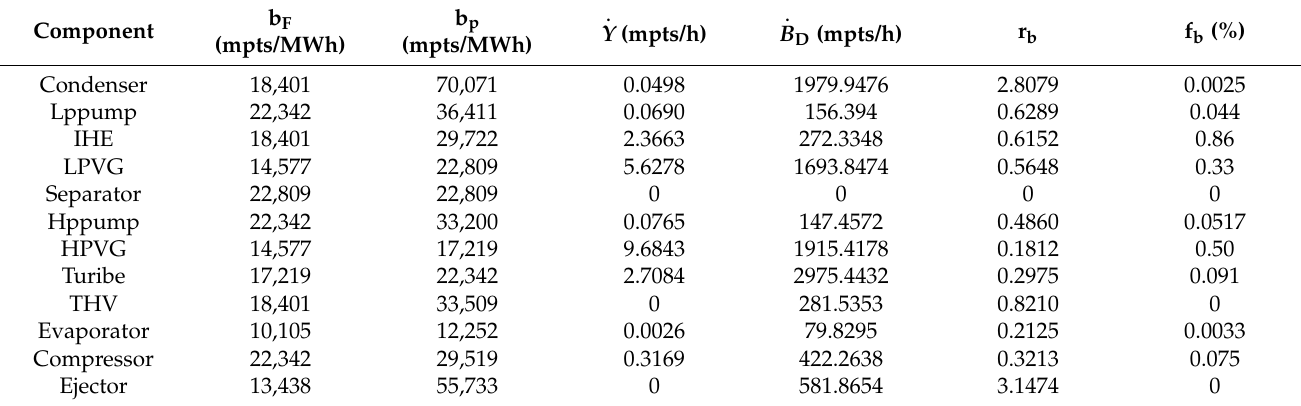
Table 13. Exergoenvironmental analysis results of system